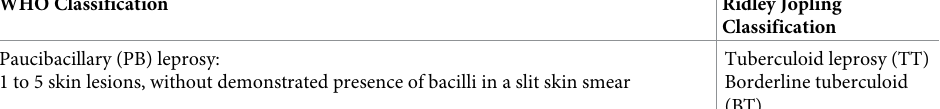
Table 2. Diagnosis of leprosy under the WHO and Ridley Jopling classification systems. WHO